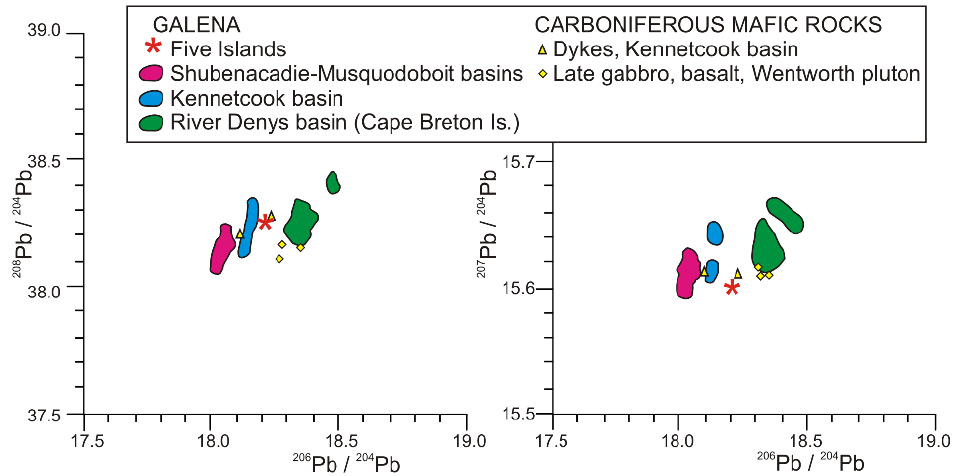
Figure 10. Lead isotope ratios from galena sample from Five Islands. Other data from galena in central Nova Scotia from [26]. Selected mafic rocks from [6].